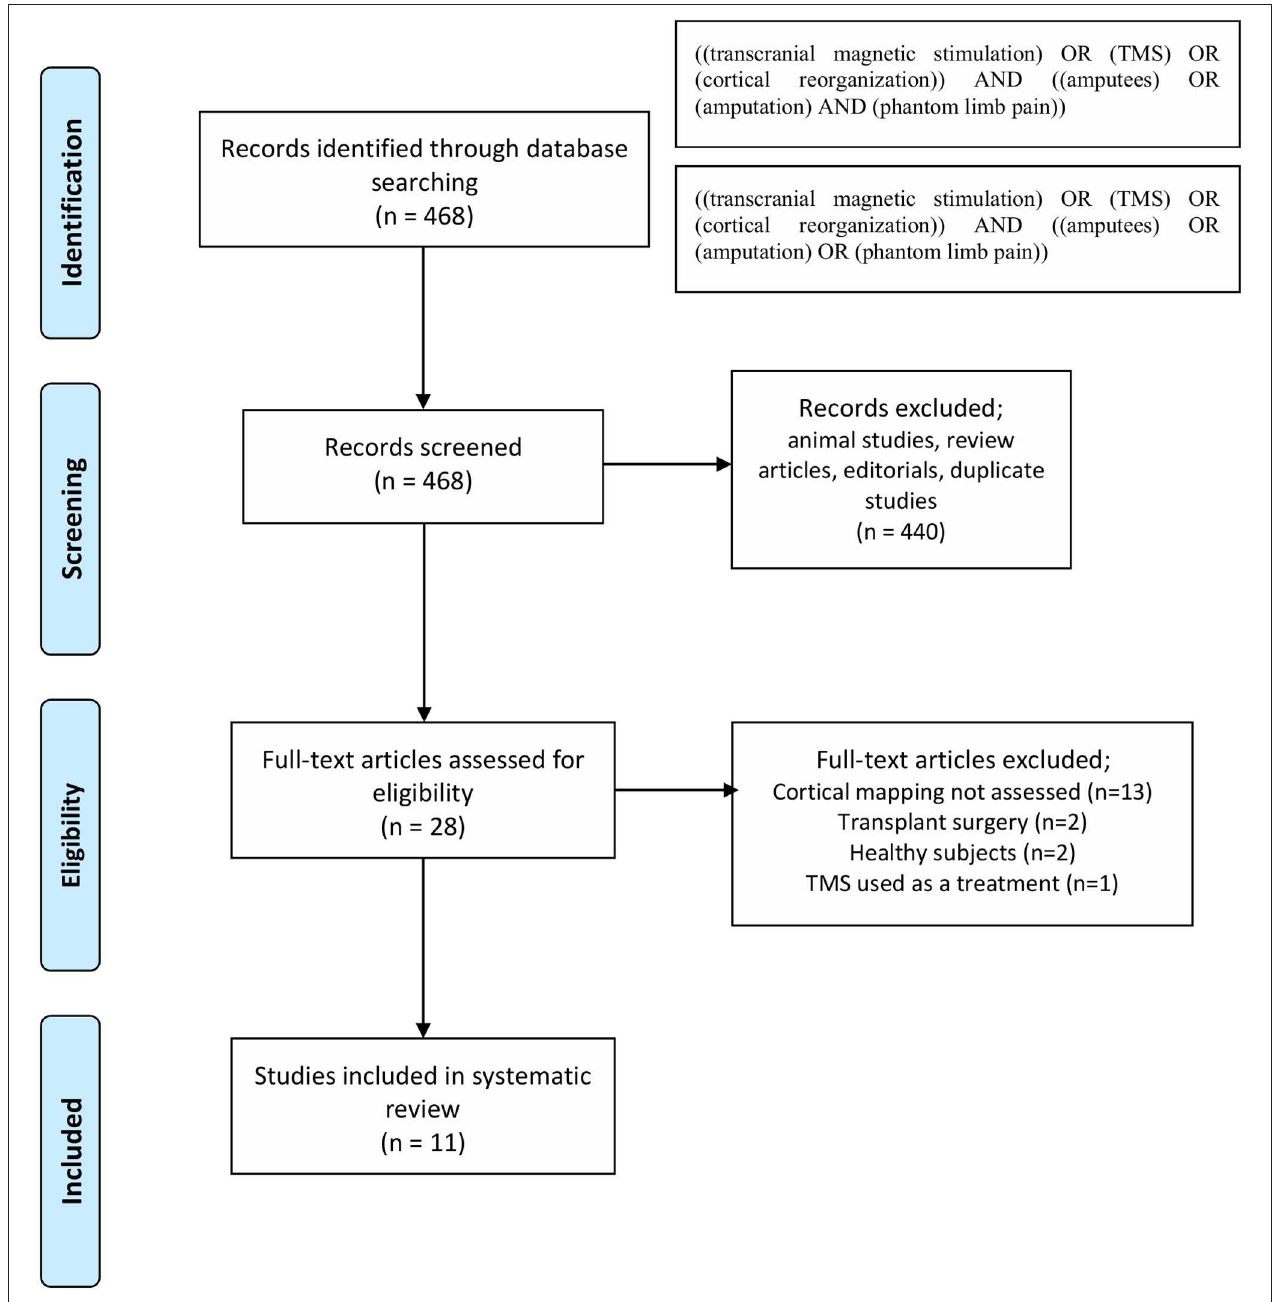
FIGURE 1 | Literature search